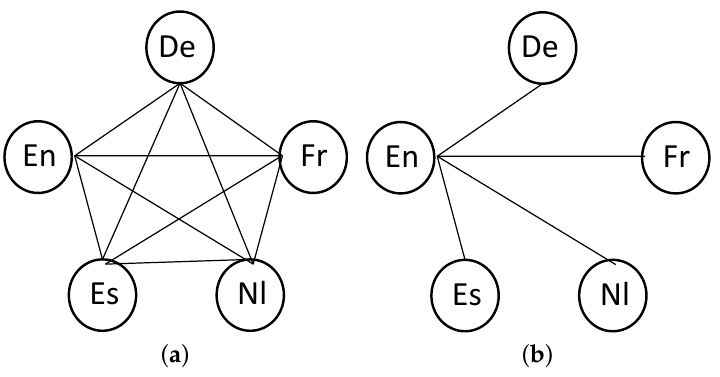
Figure 2. Source–target translation graphs in multilingual NMT. Lines indicate that direct parallel data exist. When there is no line connecting any two languages, the zero-shot translation approach can be applied. ( a ) M2M ( b )